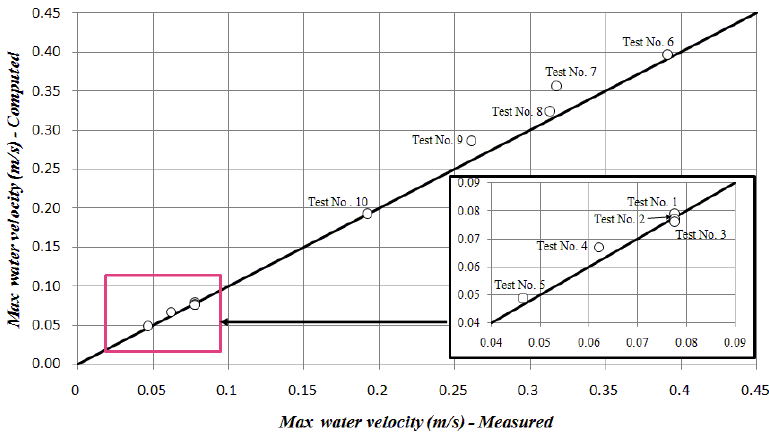
Figure 10. Comparison between computed and measured maximum water